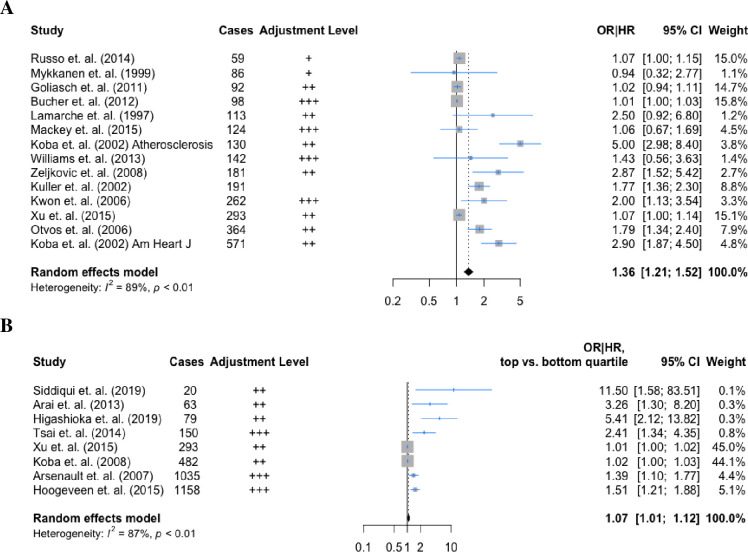
Forest plots for random effects meta-analysis of the associations between (A) sdLDL, (B) sdLDL-C and CHD.‘+’ = adjusted for other lipid subfractions; ‘++’ = adjusted for demographics and lifestyle risk factors; ‘+++’ = adjusted for demographics, lifestyle risk factors and lipid subfractions. Maximally adjusted hazard ratios from each study were used. Kuller et. al. provided an unadjusted estimate only.